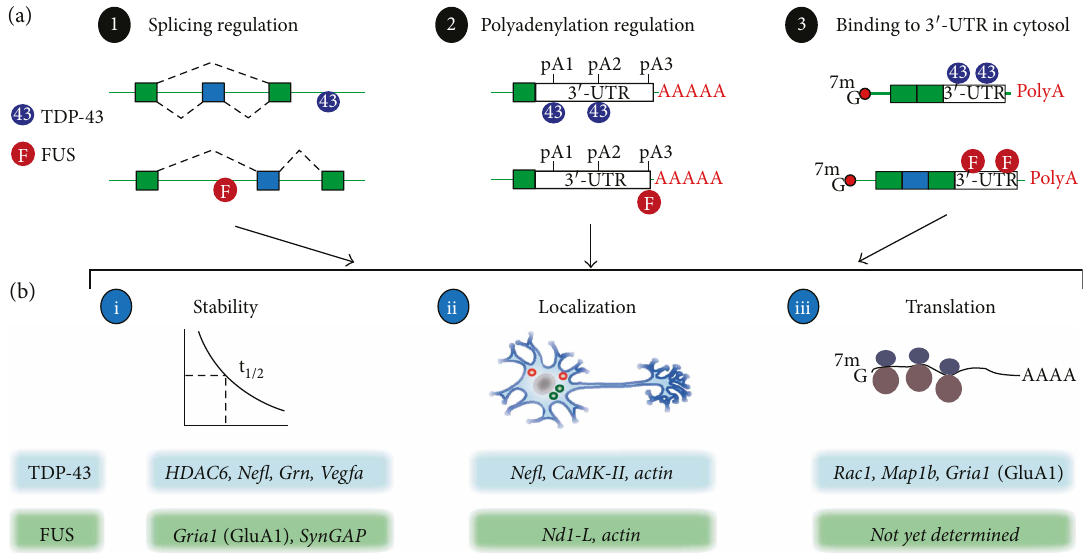
Figure 2: Physiological roles of TDP-43 and FUS/TLS in RNA processing. (a) 3 main functions of TDP-43 and FUS on RNA processing: splicing regulation, polyadenylation site regulation, and binding to 3 ′ -UTR. (b) The regulation by TDP-43 and FUS in fl uences the fates of mRNAs, stability, localization, and translation. Some of the known regulated targets are listed for TDP-43 and